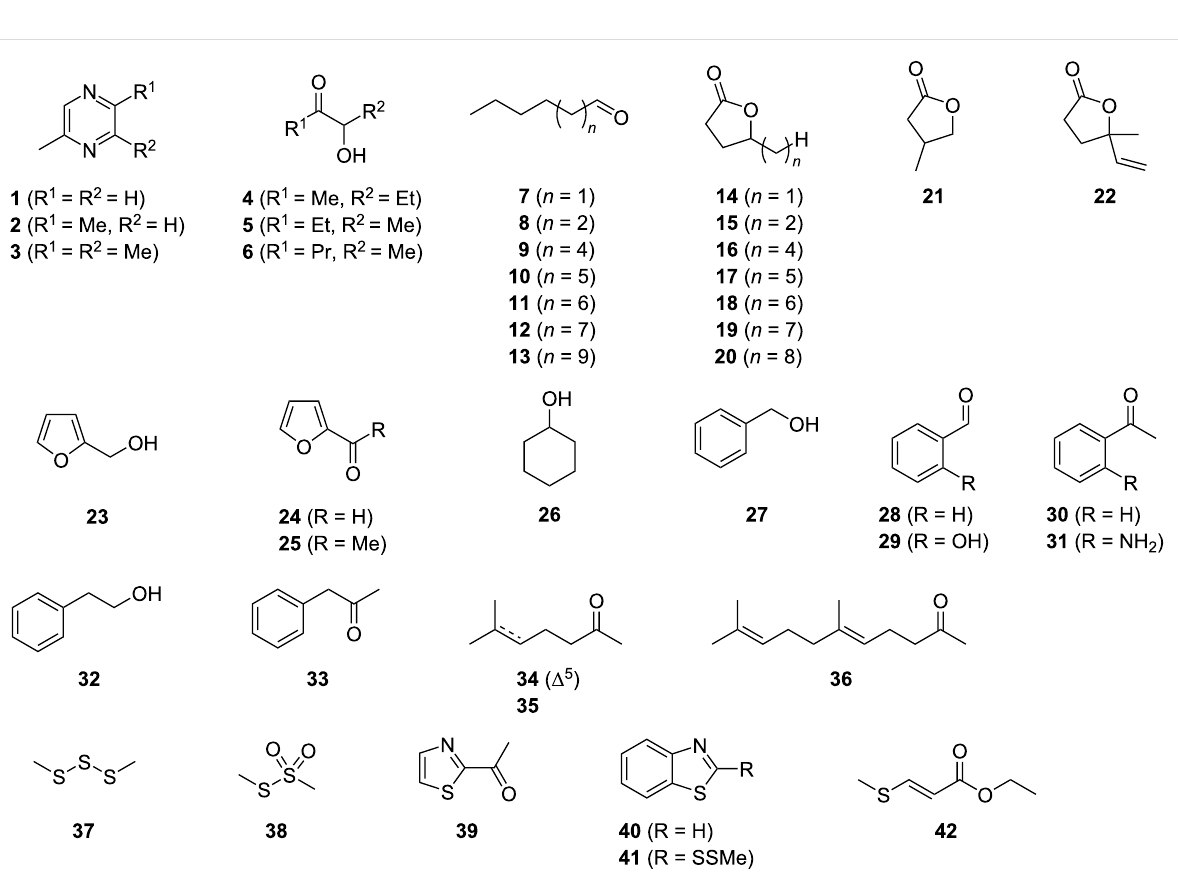
Figure 2: Structures of the identified volatile compounds in the headspace extracts from six Celeribacter type strains.